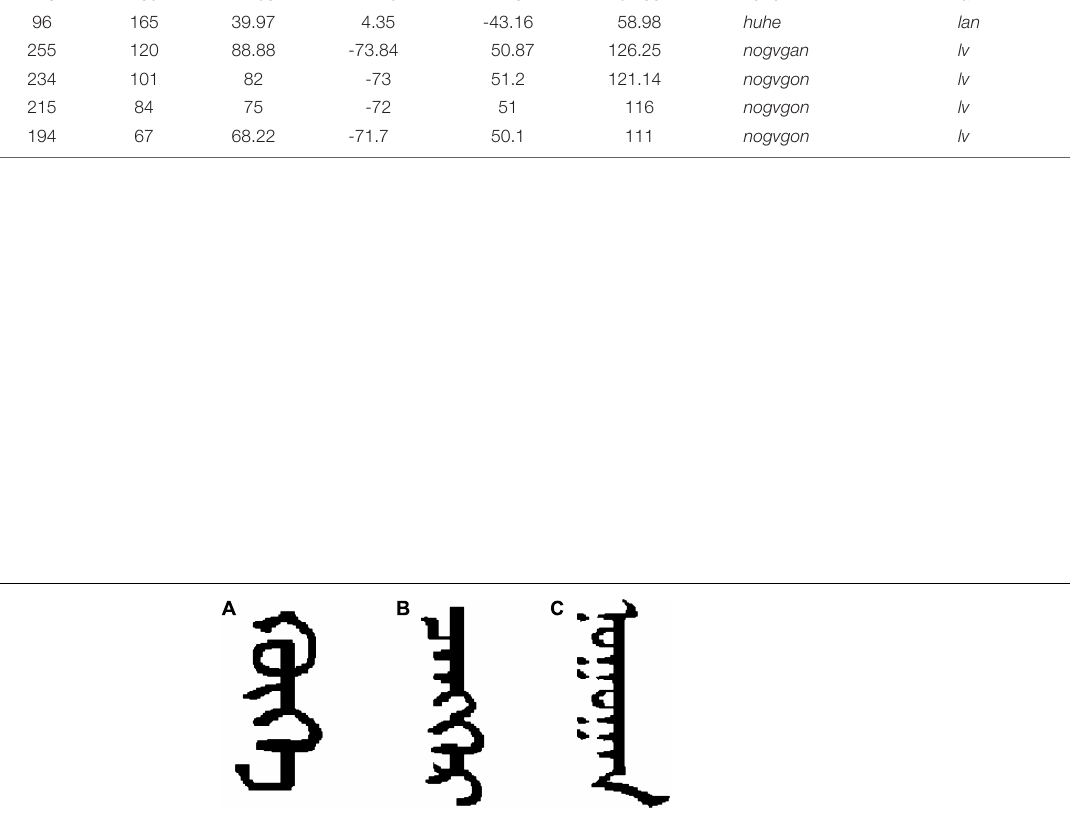
FIGURE A1 | Color terms in Mongolian: (A) dark blue (“ Shen Lan” in Chinese, / huhe /in Mongolian), (B) light blue (“ Qian Lan ” in Chinese, / qinker /in Mongolian), and (C) green (“ lv ” in Chinese, / nogvgan / in Mongolian).